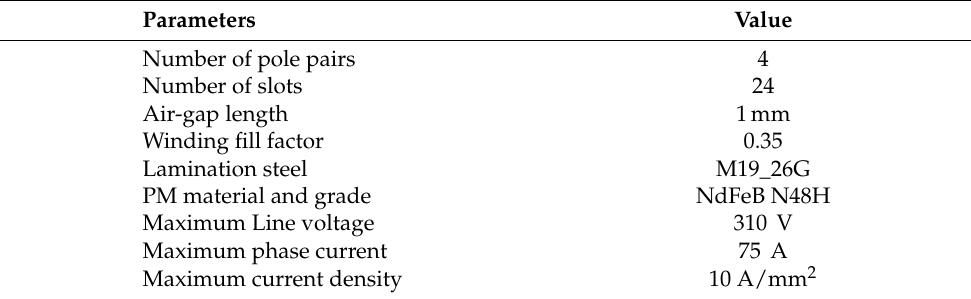
Figure 7. Cross section of motor parameters . Table 4. Motor design